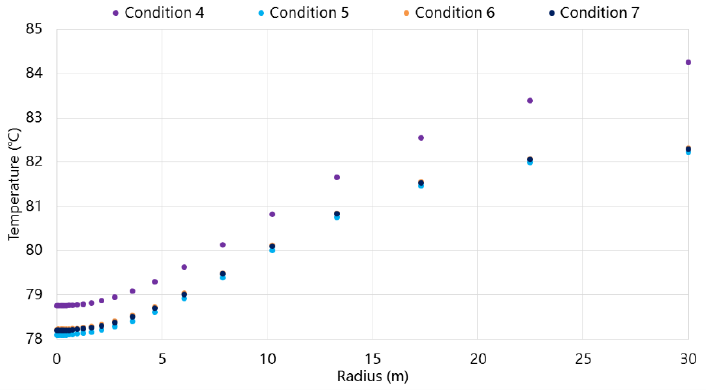
Figure 29. Ground temperature distribution at the depth of 2500 m with different boundary